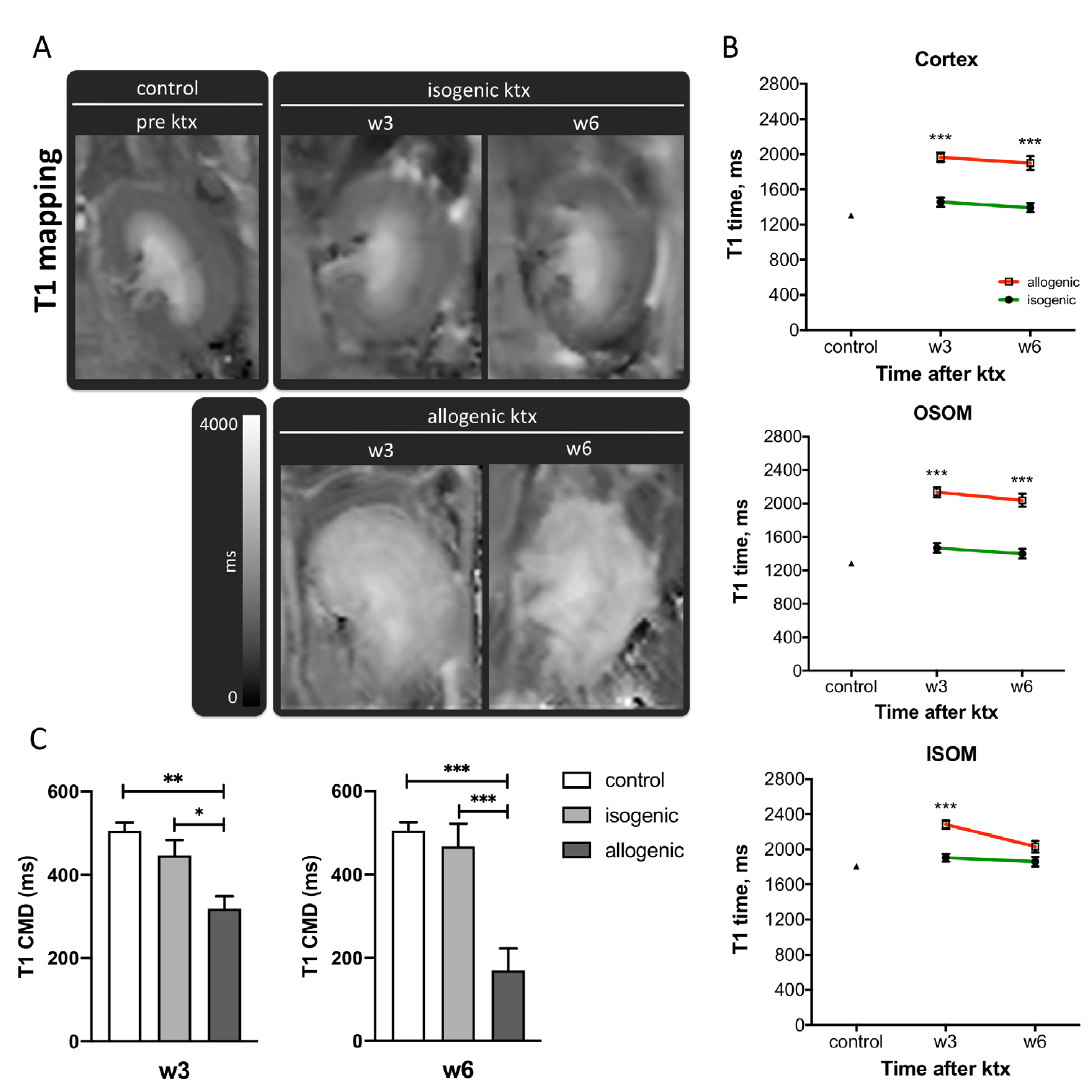
Figure 1. T1 relaxation time of renal tissue after ktx. Representative T1 maps of a normal control kidney, isogenic and allogenic kidney grafts at week 3 (w3) and week 6 (w6) after transplantation are shown ( A ). Image size, window level and width are similar. Means ± SEM of T1 values in the cortex, the outer stripe of the outer medulla (OSOM) and the inner stripe of the outer medulla (ISOM) ( B ) as well as the cortico-medullary difference (CMD) ( C ) are shown. Significant differences between isogenic and allogenic ktx are indicated: * p < 0.05, ** p < 0.01, *** p < 0.001. Control n = 22, isogenic ktx n = 7, allogenic ktx n = 5. Table 1. Functional MRI parameters after isogenic and allogenic kidney transplantation and in con- trol animals.